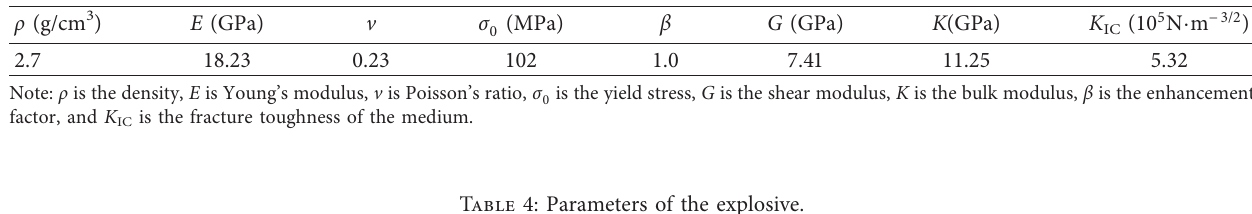
Table 3: Physical and mechanical parameters of rock.